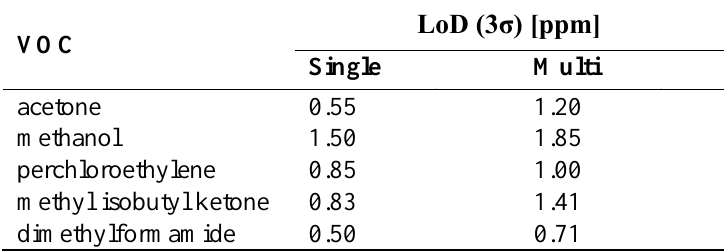
Table 7. Comparison of the detection limits: single versus and multi component. The single component detection limits (Table 4) were calculated without interference noise. The multi component detection limits including the interference of 4 other VOCs and